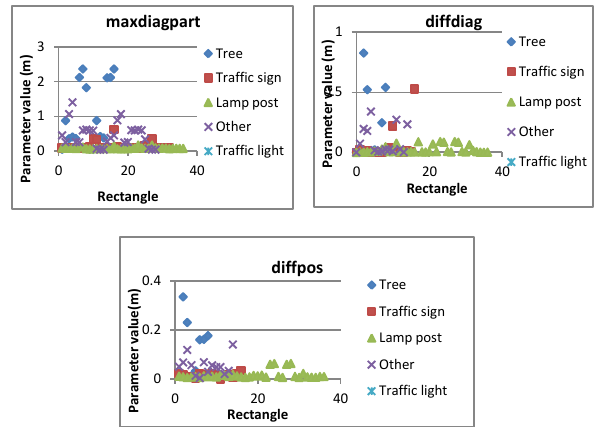
Figure 5: Statistic analysis on three parameters in percentile- based algorithm (dataset B)